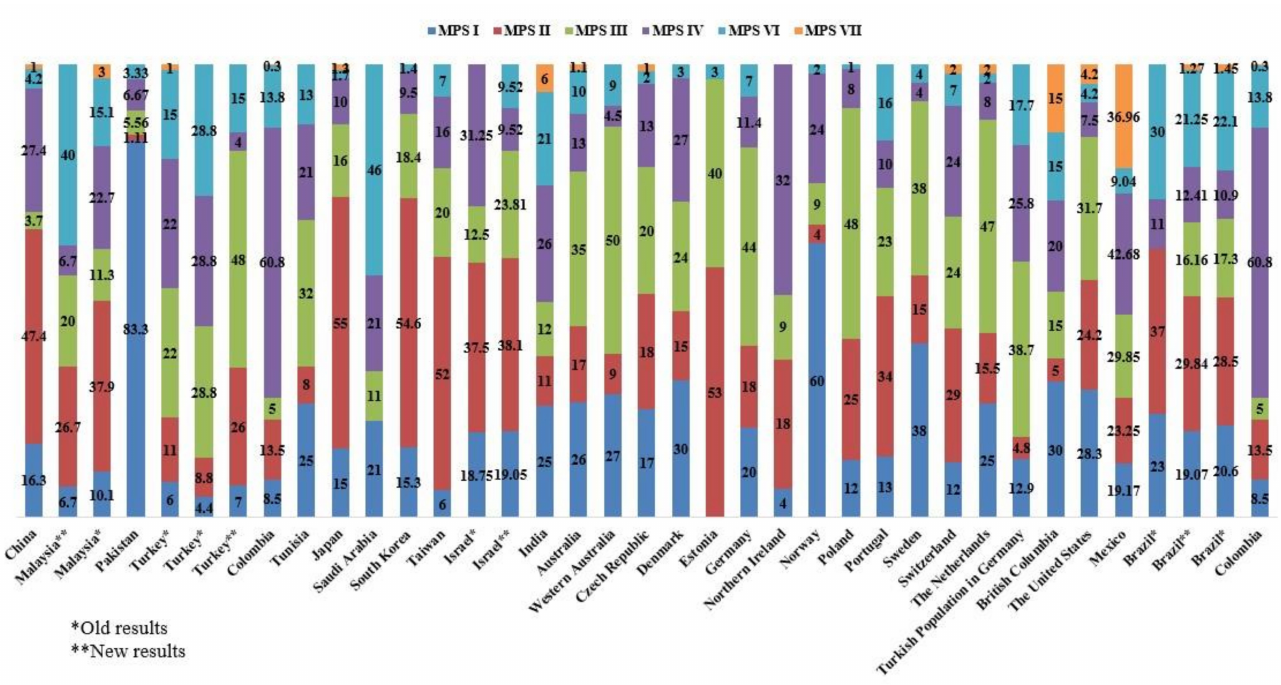
Figure 2. Incidence of MPS (%), Adapted from